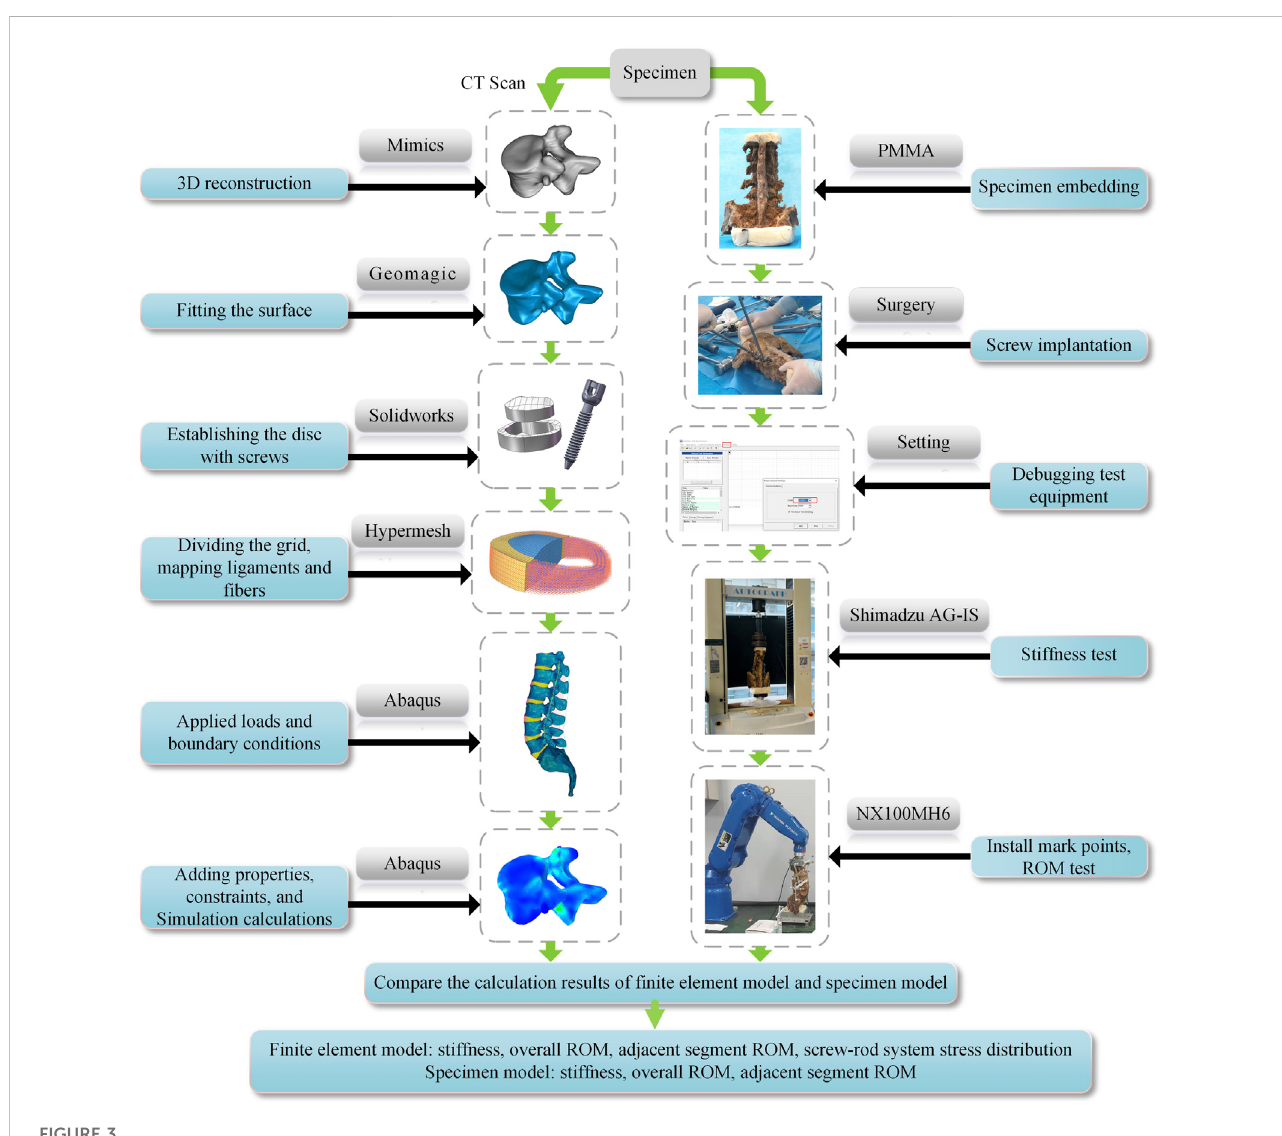
FIGURE 3 Flow chart of FEA and